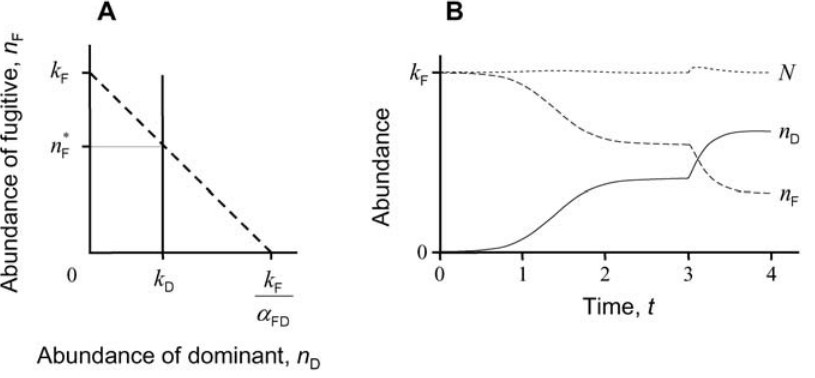
Figure 1. Equilibrium coexistence of a fugitive species invaded by a competitive dominant. With competition coefficients a DF =0, a FD =1, the fugitive persists provided it has the greater carrying capacity: k F /k D . 1. (A) Lotka-Volterra phase plane with steady-state abundance at the intersection of the isoclines for the fugitive (dashed line) and the dominant (solid line). (B) Equilibration of abundances over time given by Runge- Kutta solutions to Equation 1, with a 20% drop in the dominant’s intrinsic death rate, d D , imposed at t =3 (equivalent to a rightward shift in its isocline) to illustrate the constancy of N = n F + n D .